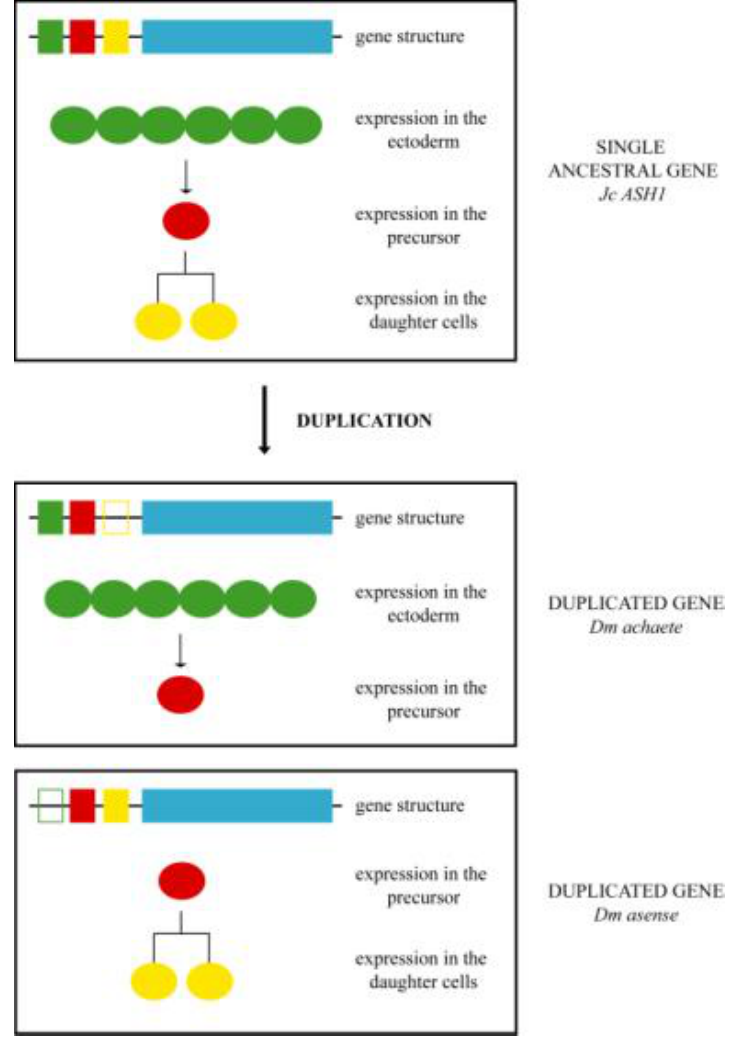
FIGURE 9 . Gene duplication and subfunctionalization. Two present-day species are shown, one with a single ancestral-like gene, the other with a gene pair resulting from a duplication of the single ancestral gene. The structure of the genes is shown: large blue boxes denote transcribed regions, small boxes represent regulatory elements that direct expression of the gene in particular cells. Solid boxes denote intact functional elements while open boxes indicate mutated nonfunctional elements. The Drosophila achaete-scute complex (here represented by achaete and asense) and its single butterfly ortholog (Jc ASH1 [Juonia coenia ASH1]) are taken as example. These genes have three types of regulatory elements that direct gene expression in the ectoderm (green), neural precursors (red), and daughters of the precursors (yellow), respectively. The single Jc ASH1 gene is expressed in these three cell types and the corresponding regulatory elements are supposed to be intact. In Drosophila, asense and achaete are only expressed in some of these cell types, the nonexpression in the other cell types is depicted as resulting from mutations that inactivate particular regulatory elements. The summed expressions of asense and achaete correspond to the expression of the single Jc ASH1 gene, hence nonfunctionalization of either of the two copies does not